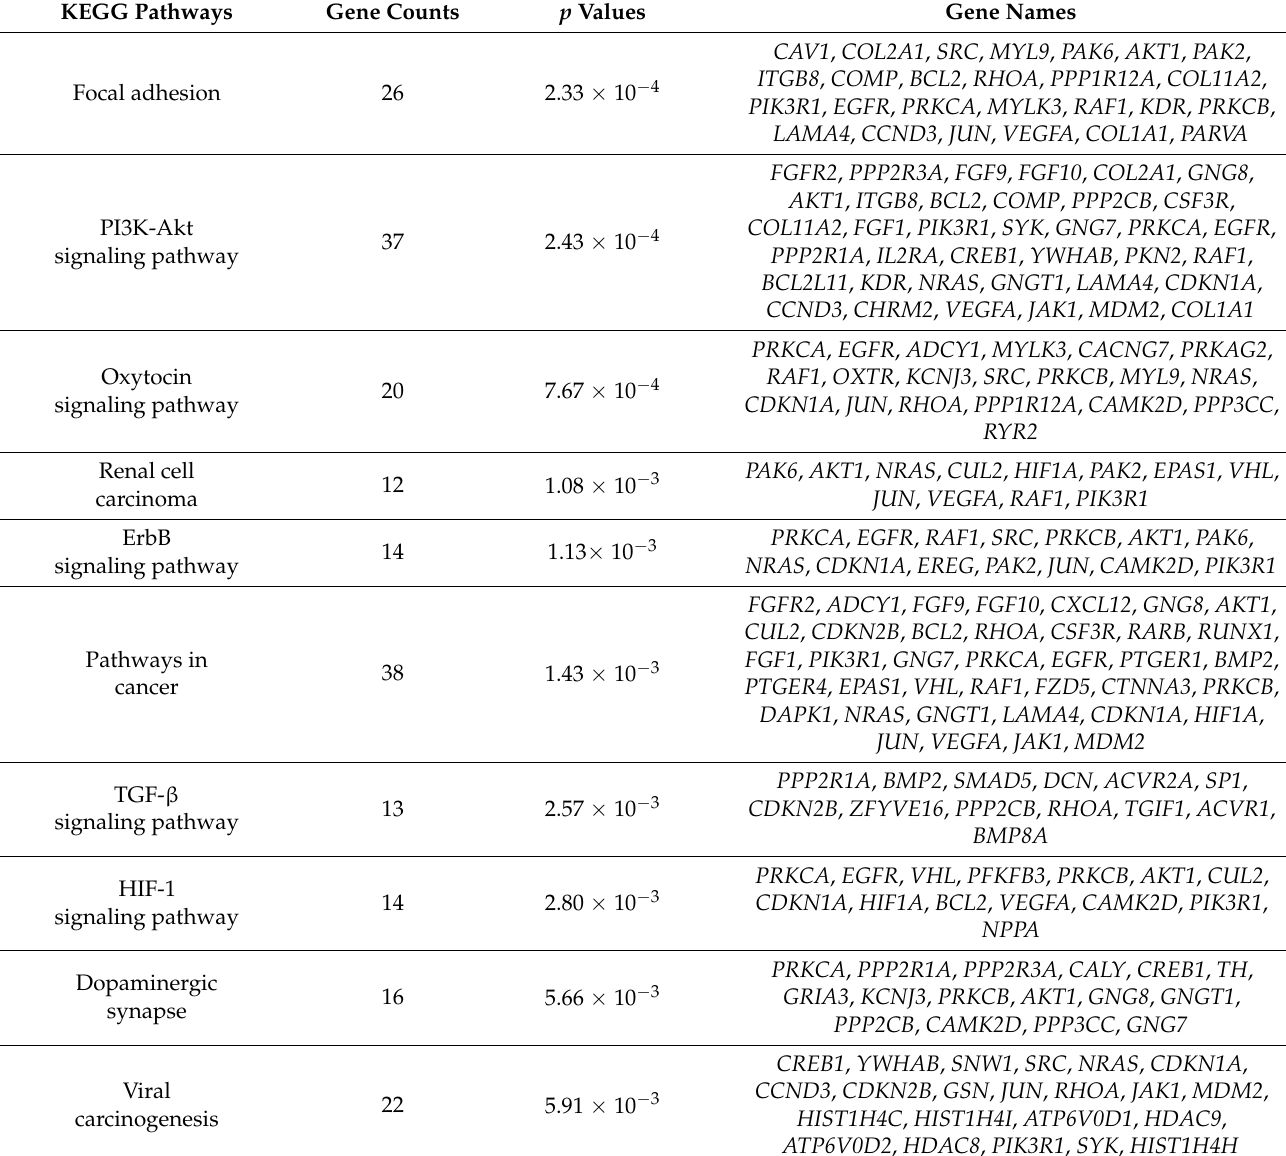
Table 1. Selective KEGG pathway enrichment analysis of all differentially expressed genes of baicalein-treated